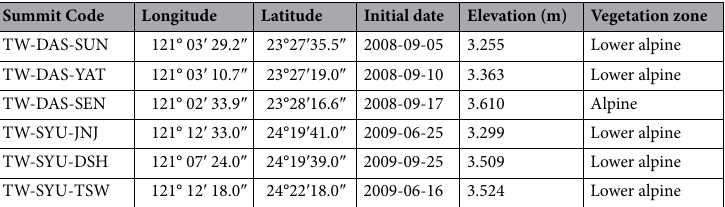
Table 1. The basic information for all summits used as study areas in our survey of vegetation in the mountains of Taiwan (adapted from Kuo et al 23